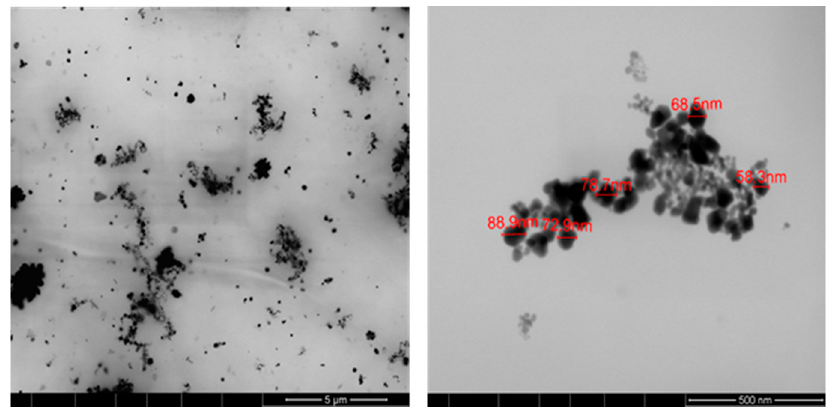
Figure 6. STEM micrographs of the Ag NPs-PEG solution with different magnifications: 5 µm and 500 nm.